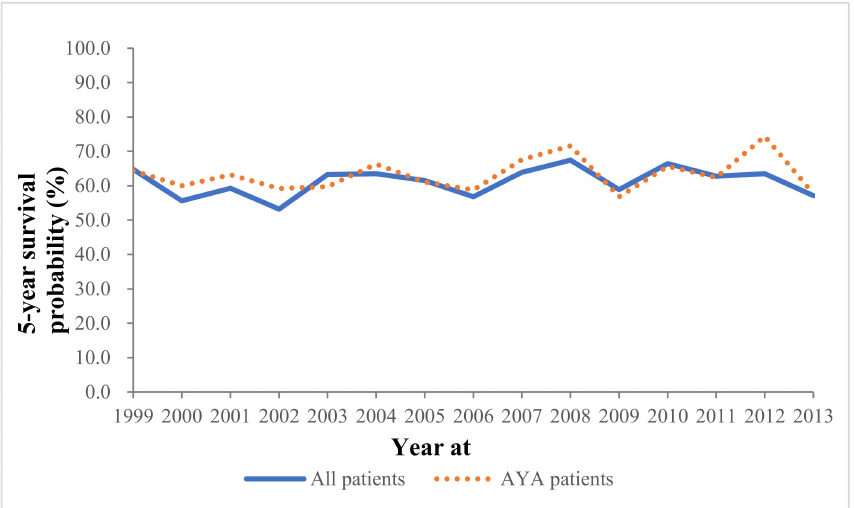
Figure 2. The 5-year overall survival trend of patients with